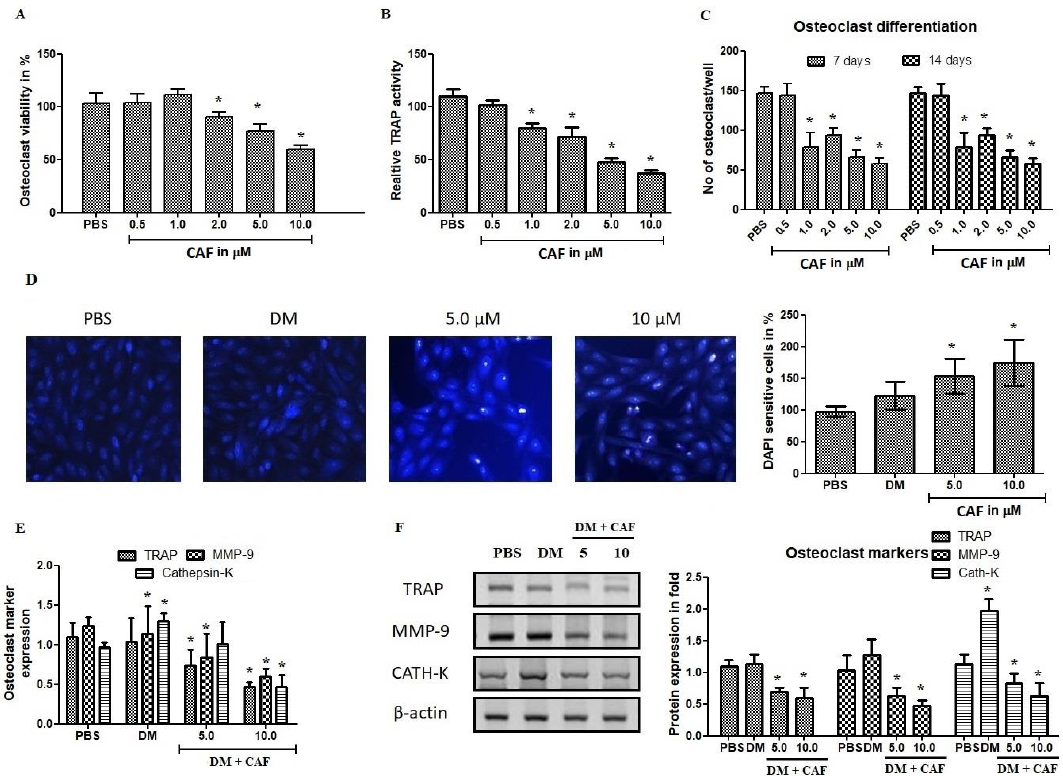
Figure 5. Effects of CAF on receptor activator of nuclear factor kappa-B ligand (RANKL)-induced osteoclast differentiation in mesenchymal cells. Bone-marrow derived mesenchymal stem cells (BM-MSCs) were cultured with vehicle or CAF (5 and 10 µM) in the presence RANKL (100 ng/mL) for 7 days. ( A ) Cultured cells tested against CAF treatment and analysed the cell viability. Cell viability of BM-MSCs was determined using the XTT assay ( B ) The estimation of Tartrate resistant acid phosphatase (TRAP) activity at 450 nm. ( C ) Cell differentiation effect was quantified on two intervals from 7 days to 10 days of incubation with CAF treatment. ( D ) RANKL induced osteoclast cells were treated with CAF and estimate the DAPI positive cells to confirm apoptotic induction as well as nuclear organization by fluorescence. Nuclei were stained by DAPI (blues signal). The area of DNA damage and nuclear organization was measured using ImageJ software. ( E ) Quantification of mRNA expression osteoclastic markers in CAF treated osteoclast cells using quantitative RT-PCR. The markers are TRAP, matrixmettalloprotease-9 (MMP-9), cathepsin-K (Cath-K). ( F ) Quantification of protein expression in osteoclastic cells treated with CAF using Immunoblot methods. The markers are TRAP, matrixmettalloprotease-9 (MMP-9), cathepsin-K (Cath-K). Bars represent the mean ± SD ( n = 4). Statistical results are shown as * p < 0.05.